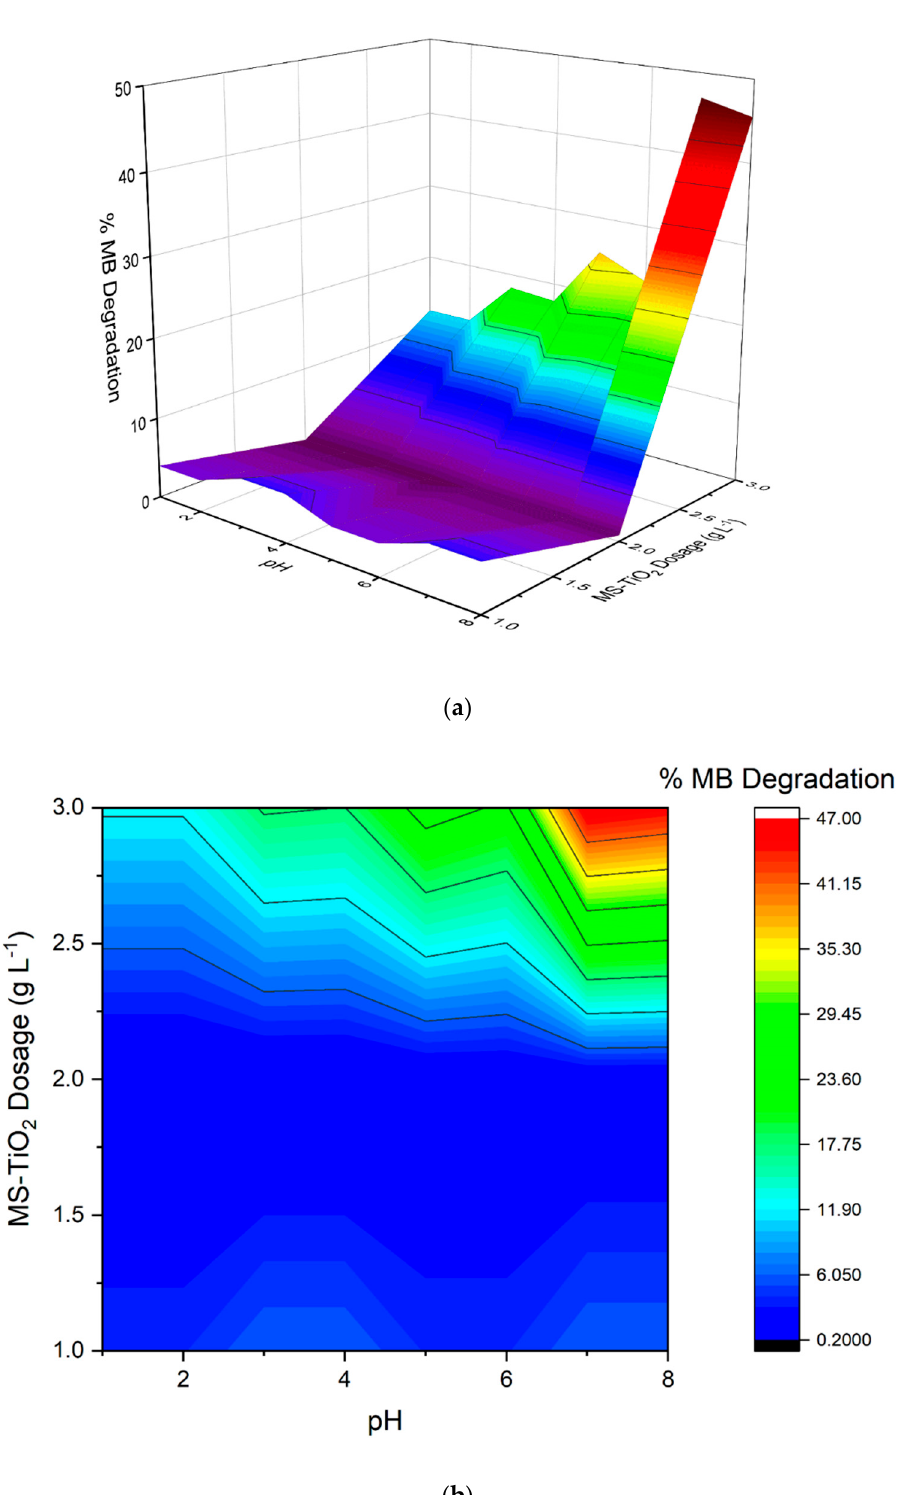
Figure 6. ( a ): Response surface plot showing the effect of pH and catalyst dosage on % degradation of MB; ( b ): 2D contour plot showing the effect of pH and catalyst dosage on % degradation of methylene blue.